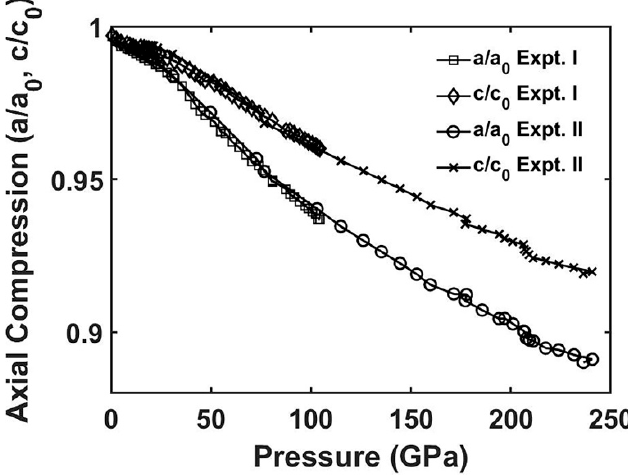
Figure 4. Axial compression of the a and c lattice parameters to 105 GPa for Experiment I and 241 GPa for Experiment II. The anisotropic compression is observed to the highest pressure of 241 GPa.